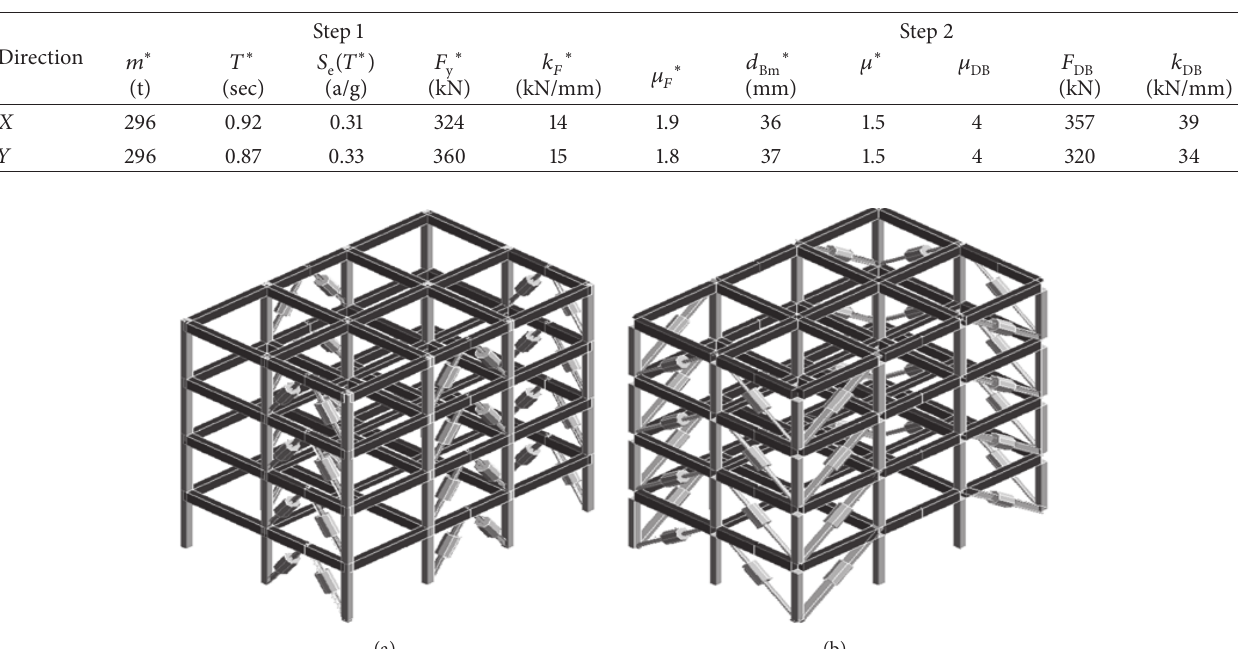
Figure 3: Numerical models of the braced structure, configuration: (a) inverted V and (b) diagonal